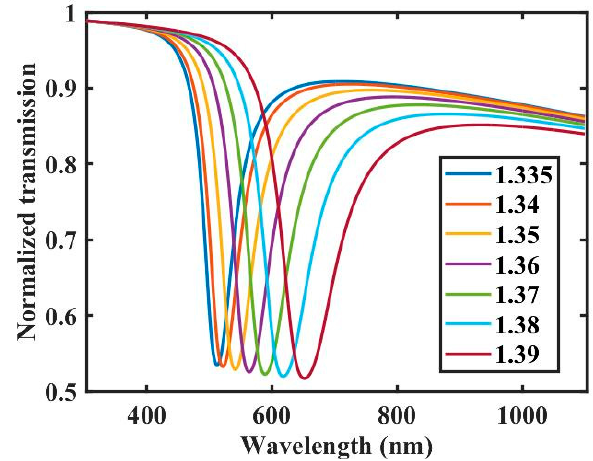
Figure 4. Simulation results of RI sensing.